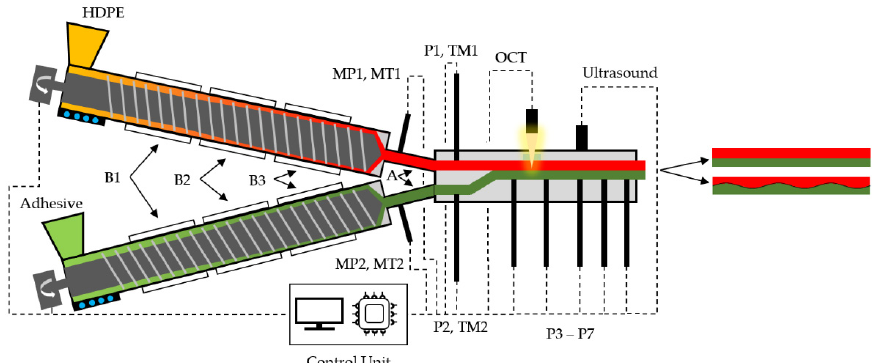
Figure 3. Schematic representation of the experimental setup with the upper-layer extruder for